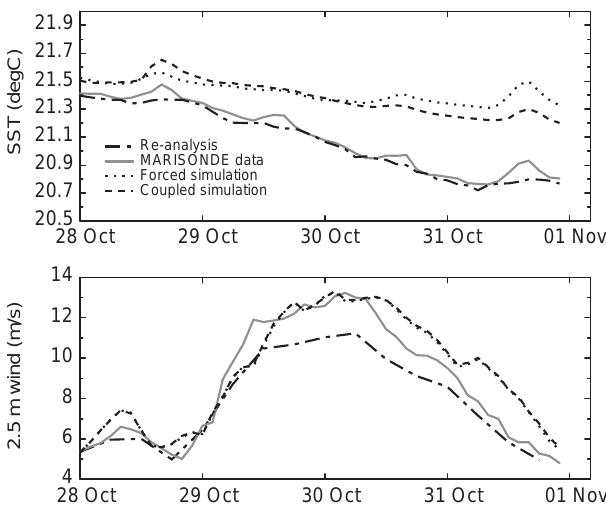
Fig. 6. From top to bottom: evolution of horizontal wind, zonal and meridional wind averaged on the simulation domain at the lowest Meso-NH vertical level (20 m). ARPEGE re-analyses ( solid line ), forced Meso-NH simulation ( dotted line ) and coupled Meso-NH simulation ( dashed